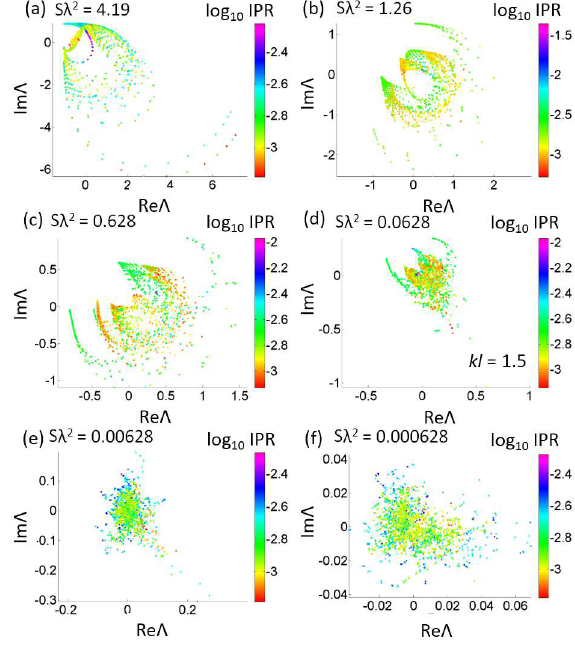
Figure 7. Eigenvalue distributions of the dyadic Green’s matrix in the complex plane for N = 1024 square array with ( a ) S λ 2 = 4.19; ( b ) S λ 2 = 1.26; ( c ) S λ 2 = 0.628; ( d ) S λ 2 = 0.0628; ( e ) S λ 2 = 0.00628; ( f ) S λ 2 = 0.000628. The color bar shows the inverse participation ratio (IPR) of the eigenmode associated to each eigenvalue in log